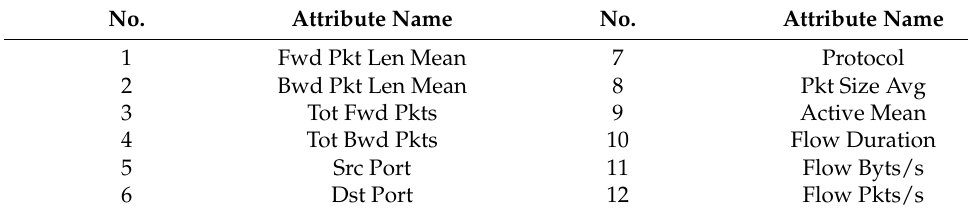
Table 6. Twelve subsets of features.